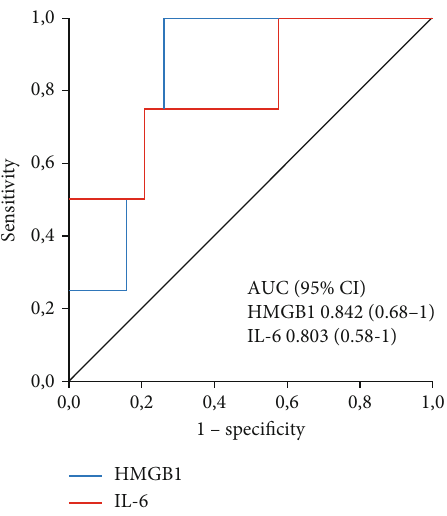
Figure 2: Receiver operator characteristic (ROC) curve and area under the curve (AUC) of HMGB1 and IL-6 in predicting one- month mortality. AUC HMGB1 = 0 : 842 (0.68 – 1); AUC IL ‐ 6 = 0 : 803 (0.58 – 1).